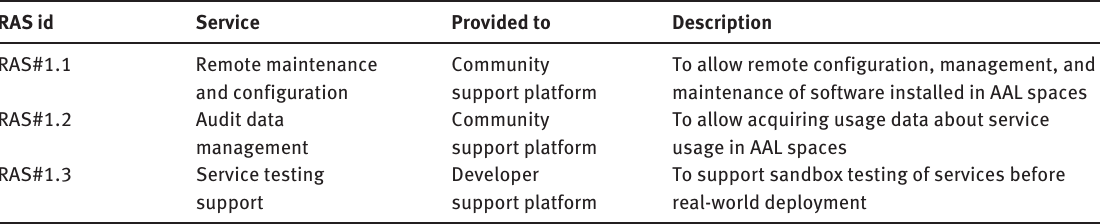
Table 2: Reference Architecture Services